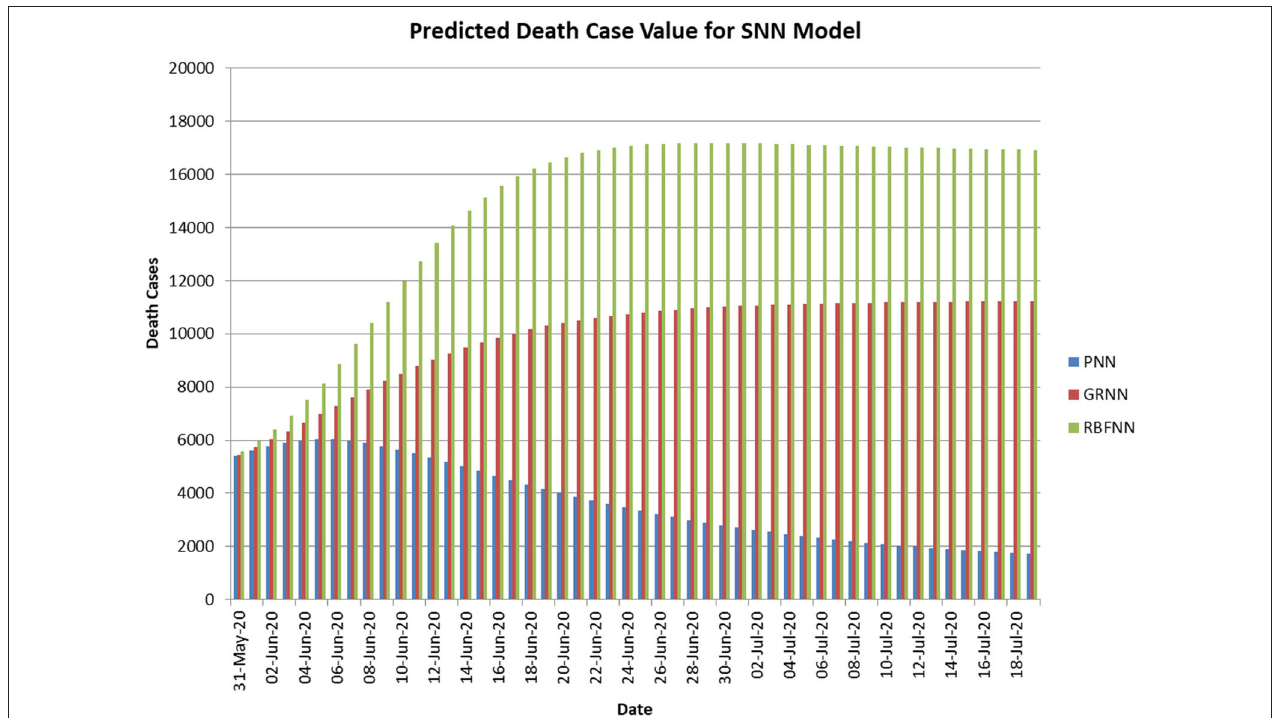
FIGURE 4 | Predicted curve for standard SNN.